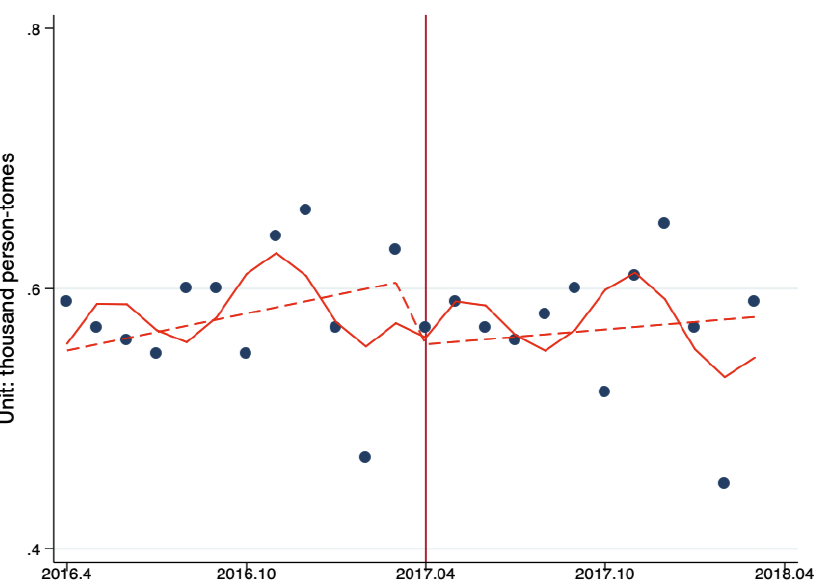
Figure 4. The ITS analysis of monthly inpatient visits in per tertiary hospital. Model adjusted for seasonality and autocorrelation. Solid line: predicted trend based on the seasonally adjusted regression model. Dashed line: de-seasonalized trend. Vertical line: intervention began. Blue dots: actual number.